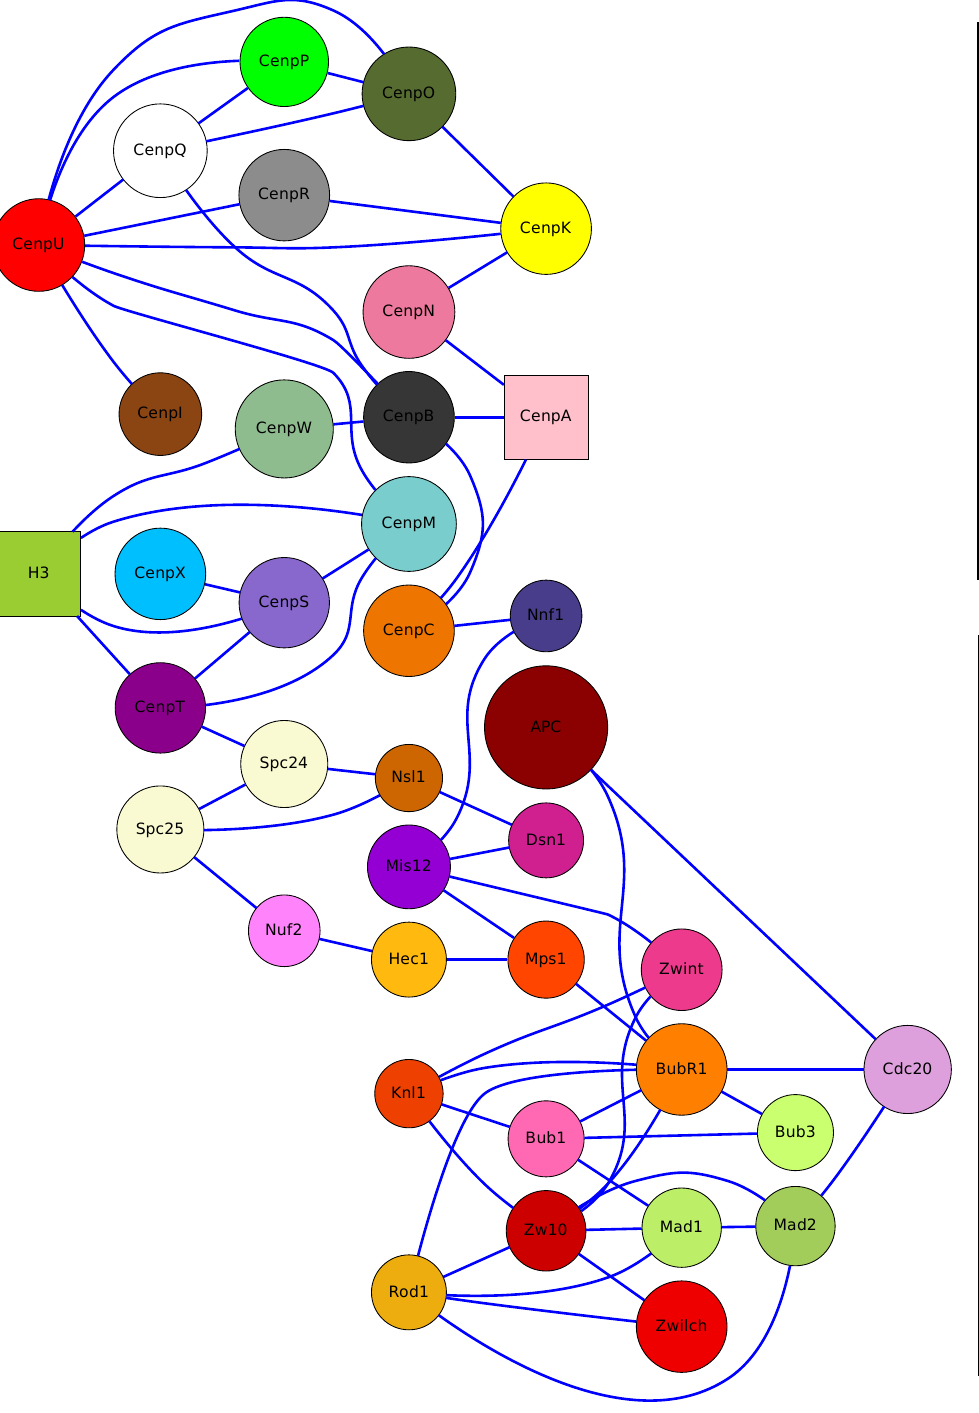
Figure 11. Map of all interactions used for the Human Mitotic Kinetochore (HMK) model (see also Table 6). The nodes in this graph represent a protein or complex, while the edges depict interactions between them. The colors and names of the vertices are the same as in Figures 9 and 12. Square shapes are the two nucleosomes, which are the anchor points for our model calculations. The CenpA nucleosome contains CenpA1, CenpA2, H41, H42, H2A1, H2A2, H2B1 and H2B2. The H3 nucleosome contains H31, H32, H43, H44, H2A3, H2A4, H2B3 and